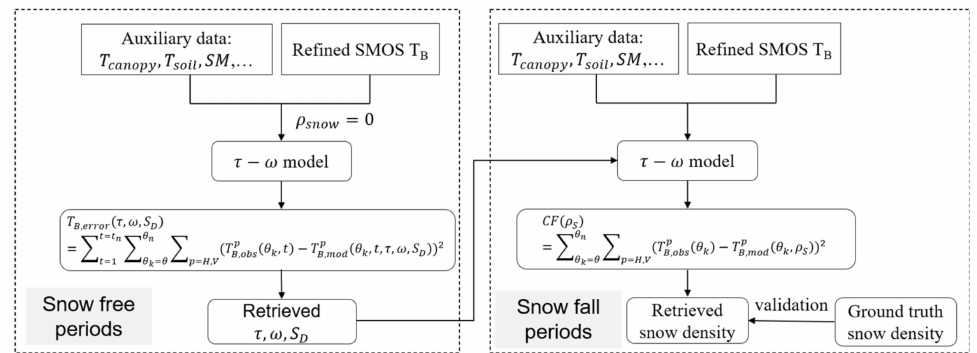
Figure 3. Flow chart for snow density